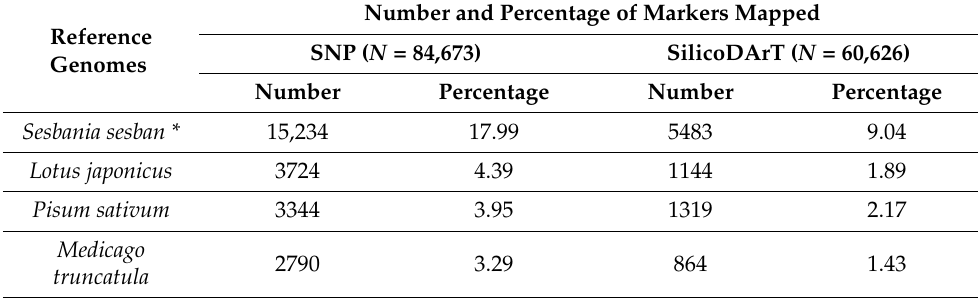
Table 1. Number of markers mapped onto reference genomes.